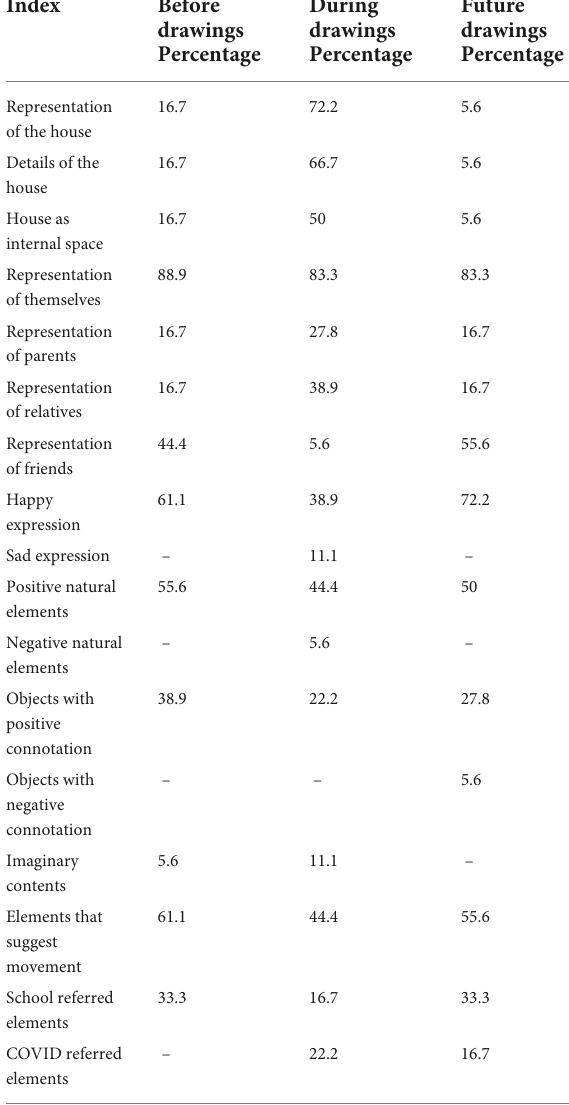
TABLE 4 Frequencies of qualitative drawing